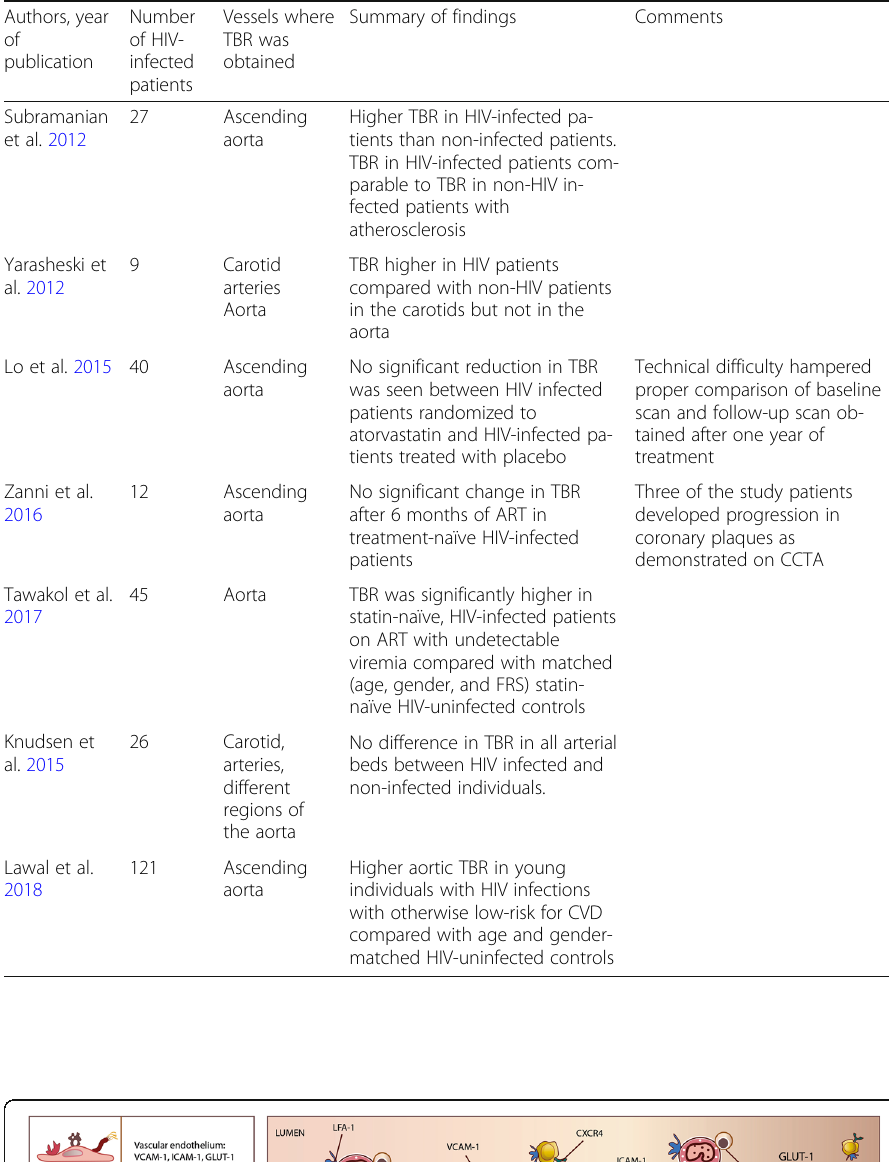
Table 1 Summary of studies utilizing F-18 FDG PET/CT in the evaluation of arterial inflammation in